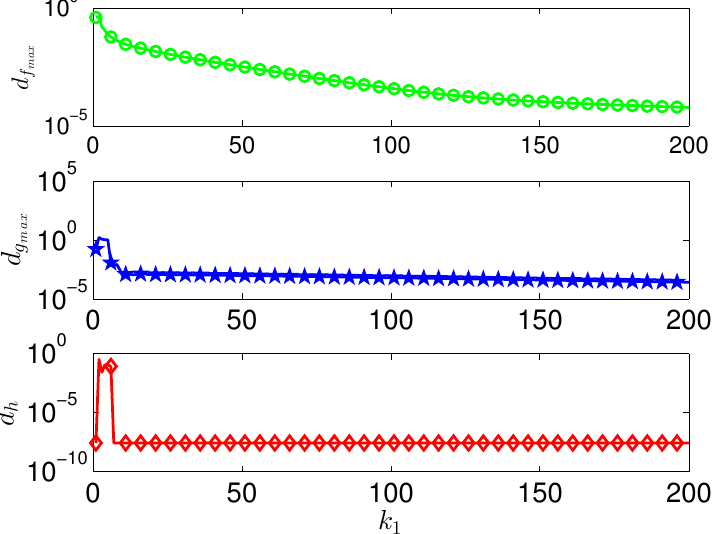
Figure 3. The residuals of (60b) to (60d) vs the k 1 of Algorithm